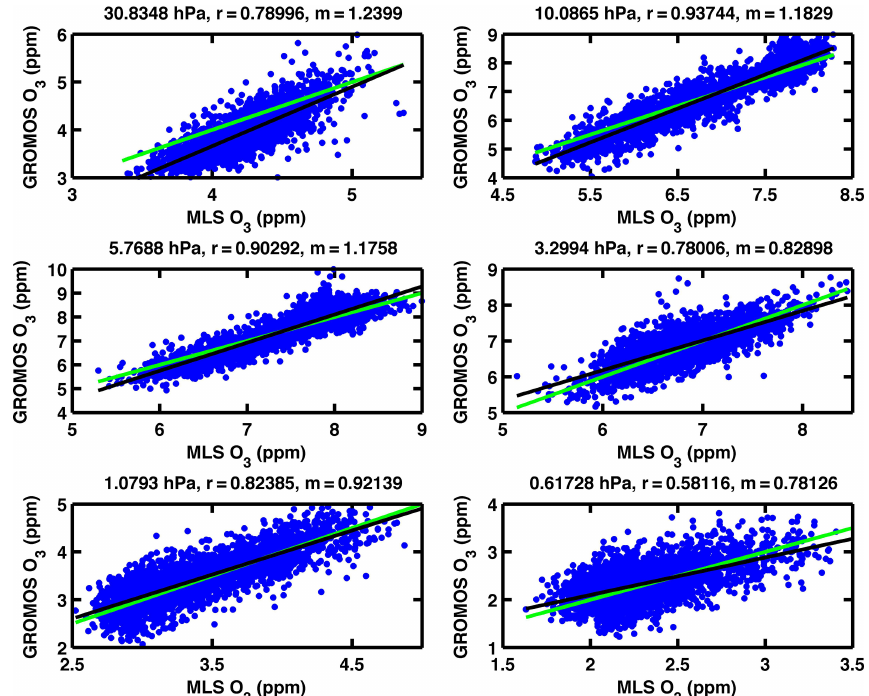
Figure 5. Scatter plots of coincident O 3 VMR measurements of GROMOS and MLS for the period from July 2009 to November 2016 at different pressure levels. The black line is the linear fit of both time series, and m is the slope of the linear fit. The green line indicates the case of identity, O 3 (MLS) = O 3 (GROMOS). r values are correlation coefficients of the MLS and GROMOS time